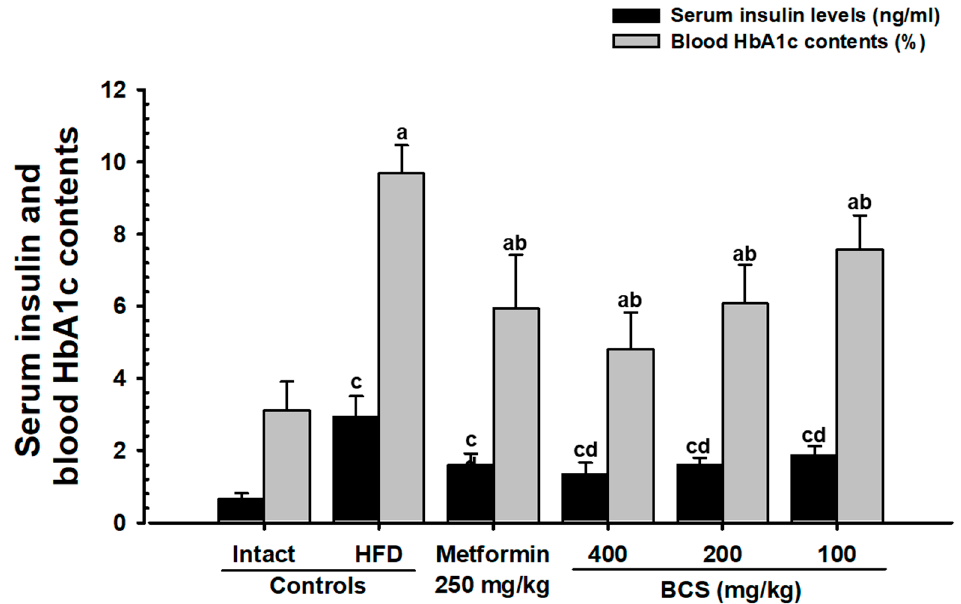
Figure 1. Insulin content and HbA1c ratio in NFD- or HFD-supplied groups. DT3: Dunne tt ’s T3